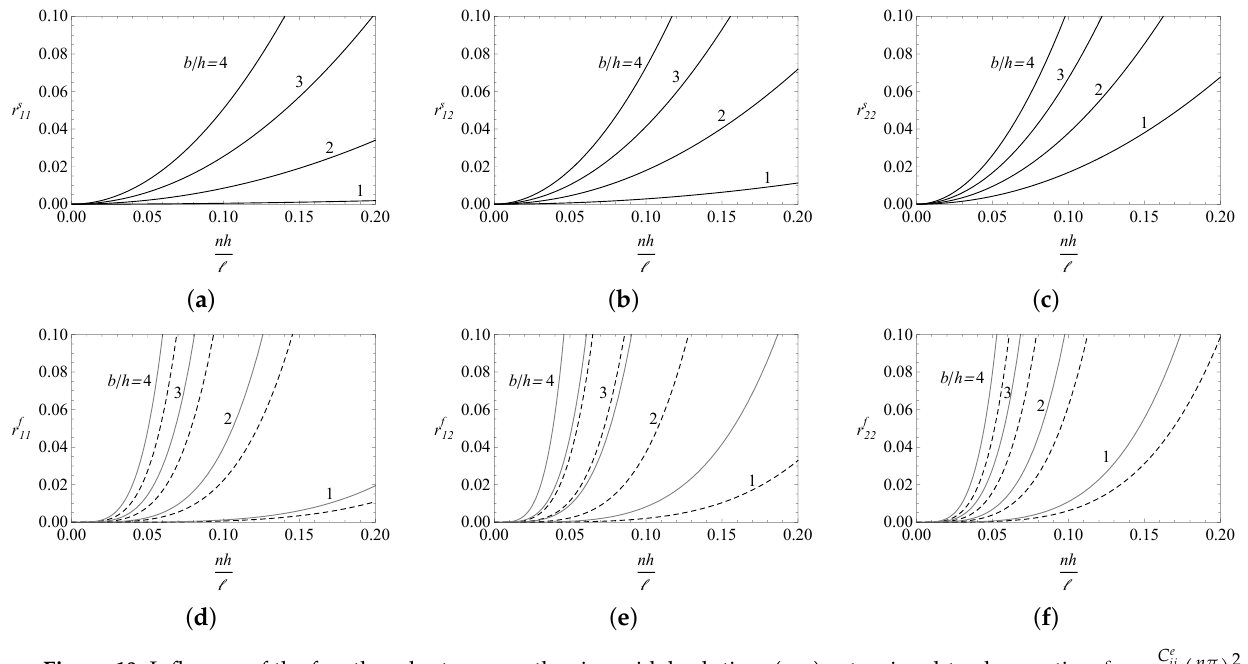
C e ij (cid:0) n π (cid:1) 4 : = vs. the squatness ratio nh (cid:96) for different aspect ratios b (cid:96) ij B f 22 = 1.4 t 2 1